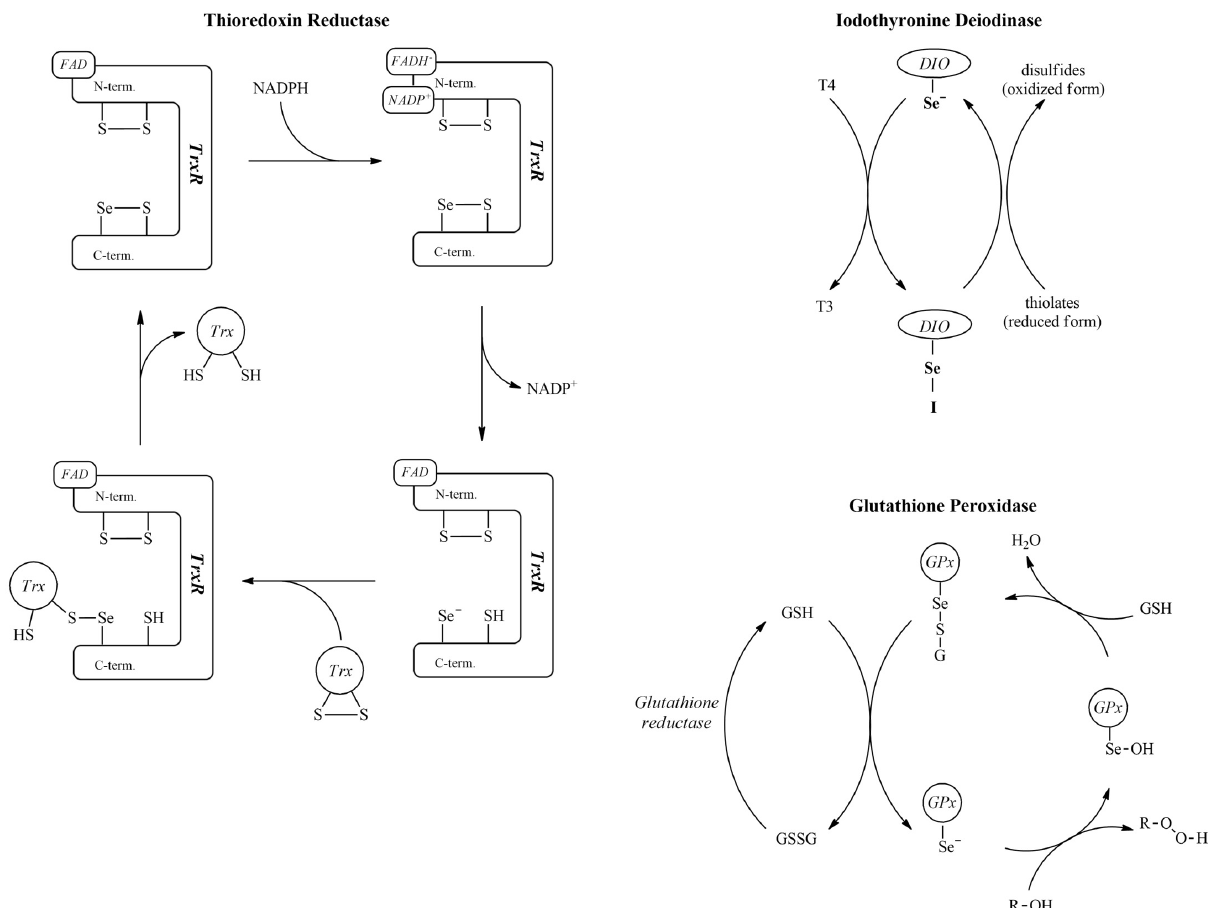
Figure 3. Catalytic mechanism of some selenoprotein enzymes: thioredoxin-dependent reduction using NADPH and FAD; redox cycle of glutathione peroxidase involving selenenic acid intermediate; deiodination mechanism of iodothyronine deiodinase.